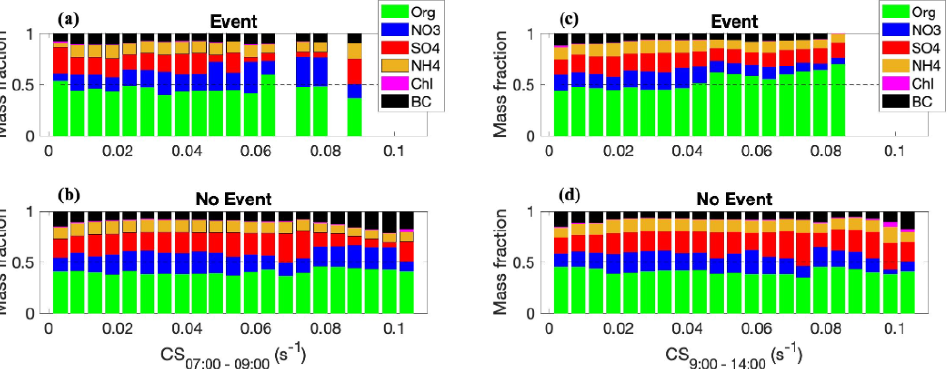
Figure 9. Mass fractions of the major compound measured before (07:00–09:00UTC, a, b ) and during (09:00–14:00UTC, c, d ) the NPF period at the ATOLL station during event (a, c) and non-event (b, d) days. The black dashed line corresponds to 50% mass fraction.